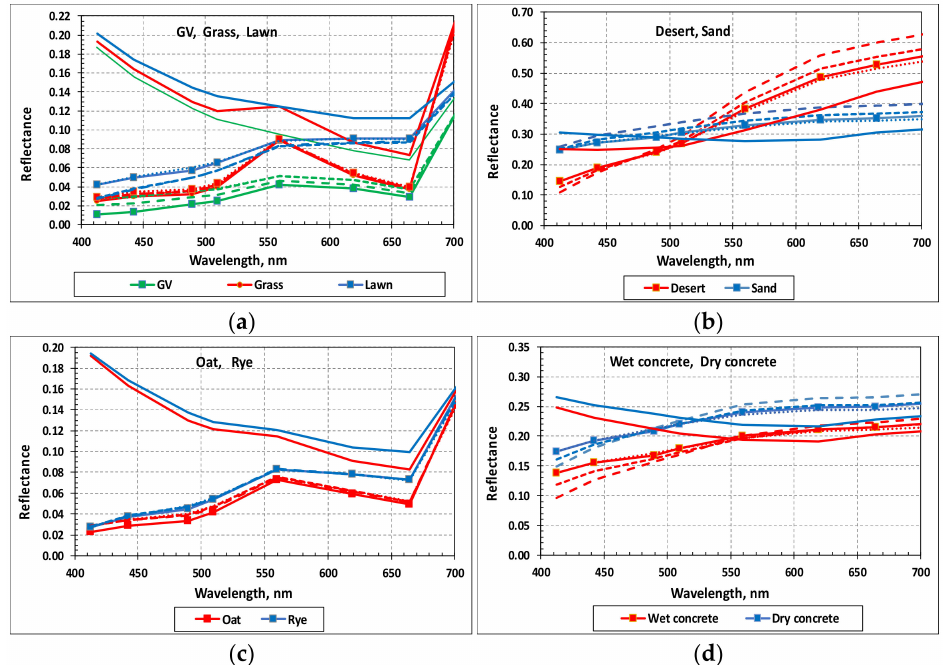
Figure 4. Reflectance of dark surfaces ( a , c ) and bright surfaces ( b , d ): true (solid lines with badges) and retrieved with three values of AOT (0.1-short strokes, 0.3-long strokes and 0.5-dash-dot), as well as the SRs at the top-of-atmosphere at AOT 0.03 (solid lines without icons).